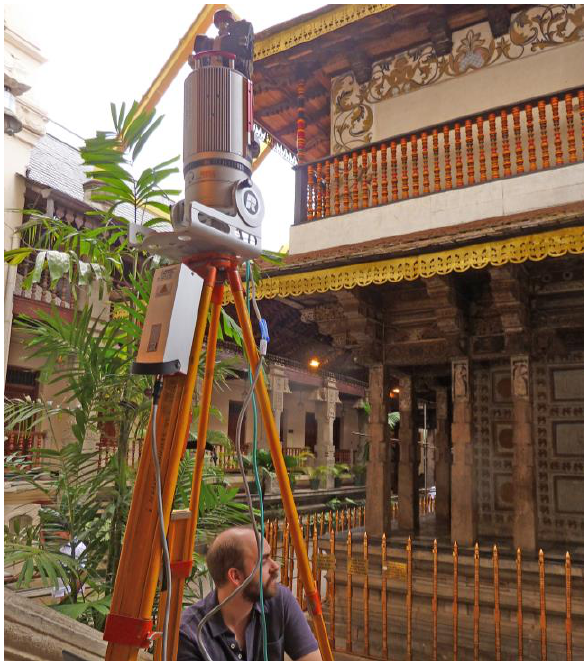
Fig. 3. 3D-Scanning at the shrine with Riegl VZ 400